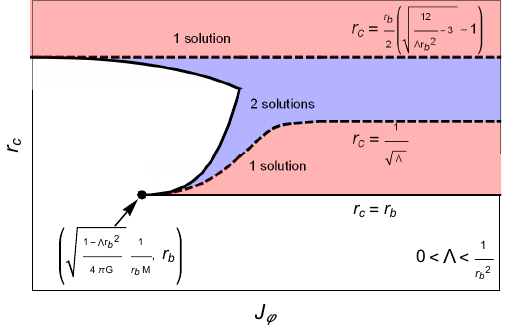
Figure 12 . Example of qualitative behavior of range of possible size of cosmological horizon r c of BG instanton against J when 0 < Λ ≤ 1 . This structure may appear when both Λ /M 2 and ϕ r 2 b r b M are large enough. This is the simplest structure. If we choose parameters that do not satisfy the above conditions, a more complicated structure will appear, such as figure 13. (An example of √ √ parameters that exhibit this structure is ( r Λ , M ) = (5 G, 0 . 012 /G, 0 . 1 / G ) ). b ,